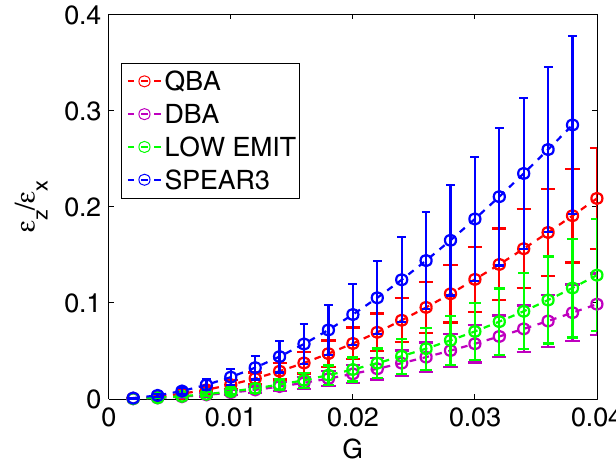
=(cid:7) is plotted vs the linear z x